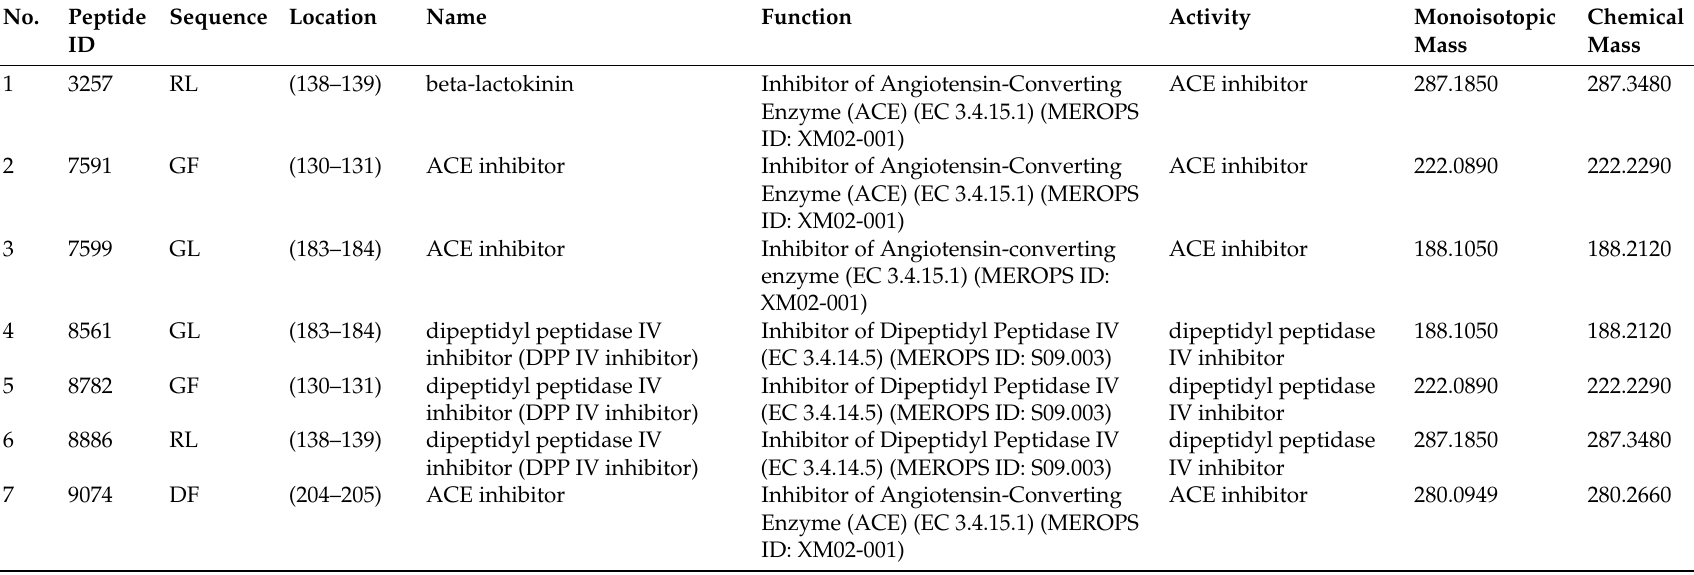
Table A35. Bioactive peptides from RubisCO of Halophila stipulacea . In silico enzymatic cleavage was carried out by using pancreatic elastase